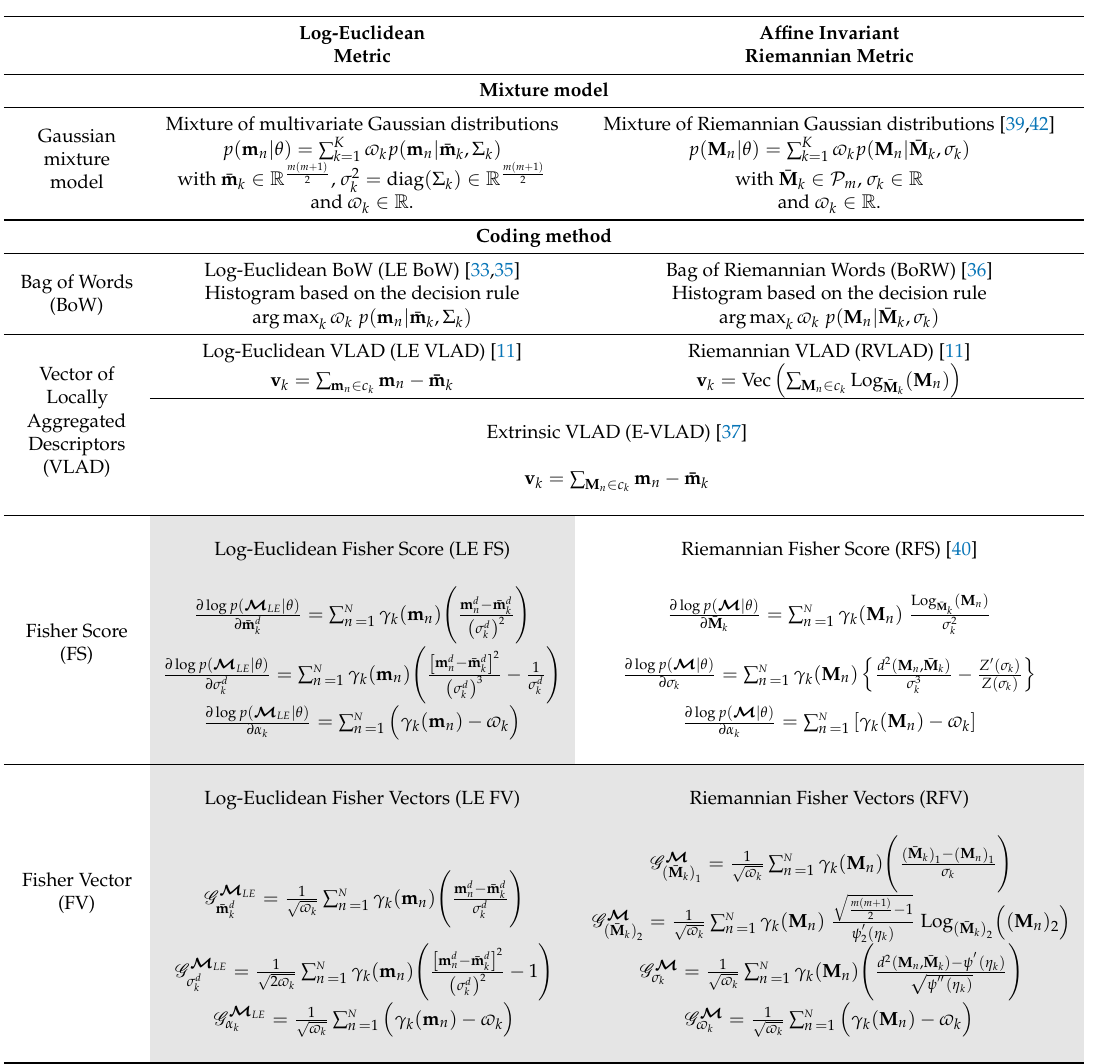
Table 1. Overview of the coding